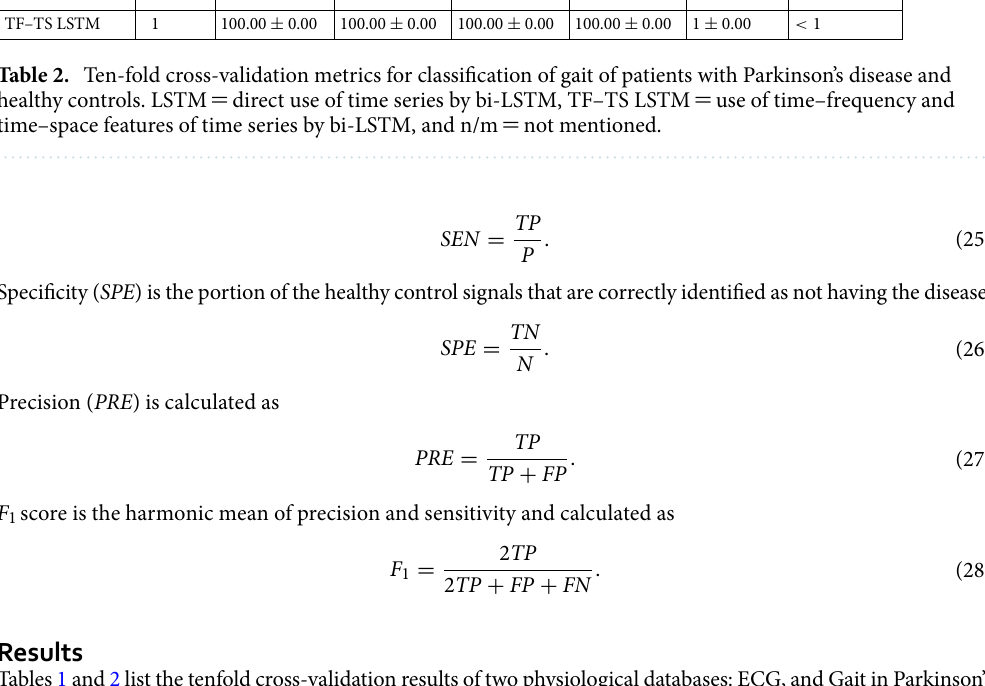
Tables 1 and 2 list the tenfold cross-validation results of two physiological databases: ECG, and Gait in Parkinson’s Disease, respectively. For the ECG database, this experiment used normal sinus rhythm (5050 signals) and AF (738 signals) for binary classification. For the Gait in Parkinson’s Disease data, this study used the time series recorded from only one sensor under the left foot labeled as L5 on the database. The purpose of selecting the sensor data recorded at the L5 location was to compare with the work reported in 47 , which used four sensors at L5, L7, R7, and R8 for the classification of gait patterns. The LSTM used in this study was the bi-LSTM (LSTM will be used as bi-LSTM subsequently). To extract the TF features, sampling frequency was set as 300 Hz. To extract the TS features, the embedding dimension = 1 , time delay = 1 , and number of clusters = 3 for computing the FRPs. The specifications of the FRP parameters were based on previous studies 25,43 , which provided satisfactorily results and were not as sensitive for constructing FRPs as for RPs 25 .